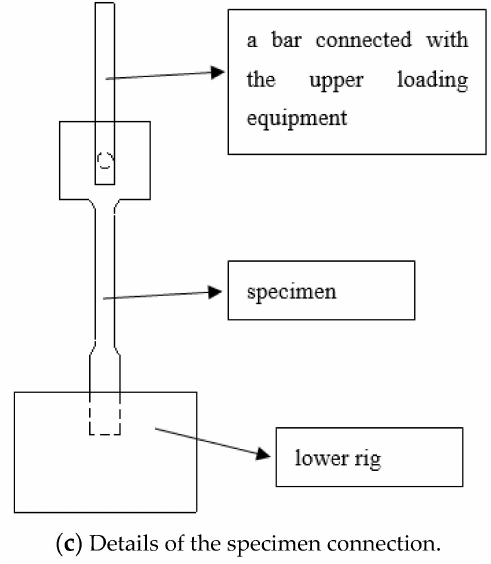
Figure 2. Quasi-static test setup at low temperatures.